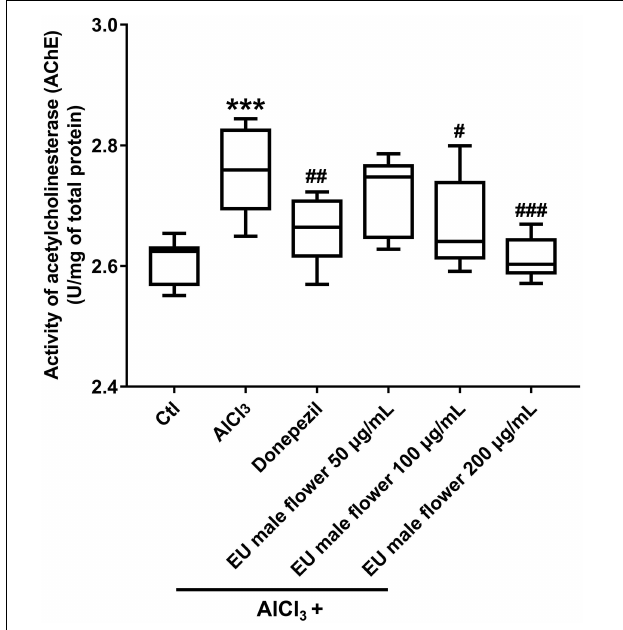
FIGURE 4 | Inhibition of EUMF on the AChE activity in zebrafish (*** P < 0.001 vs. Ctl; # P < 0.05, ## P < 0.01, ### P < 0.001 vs. AlCl 3 ; n =